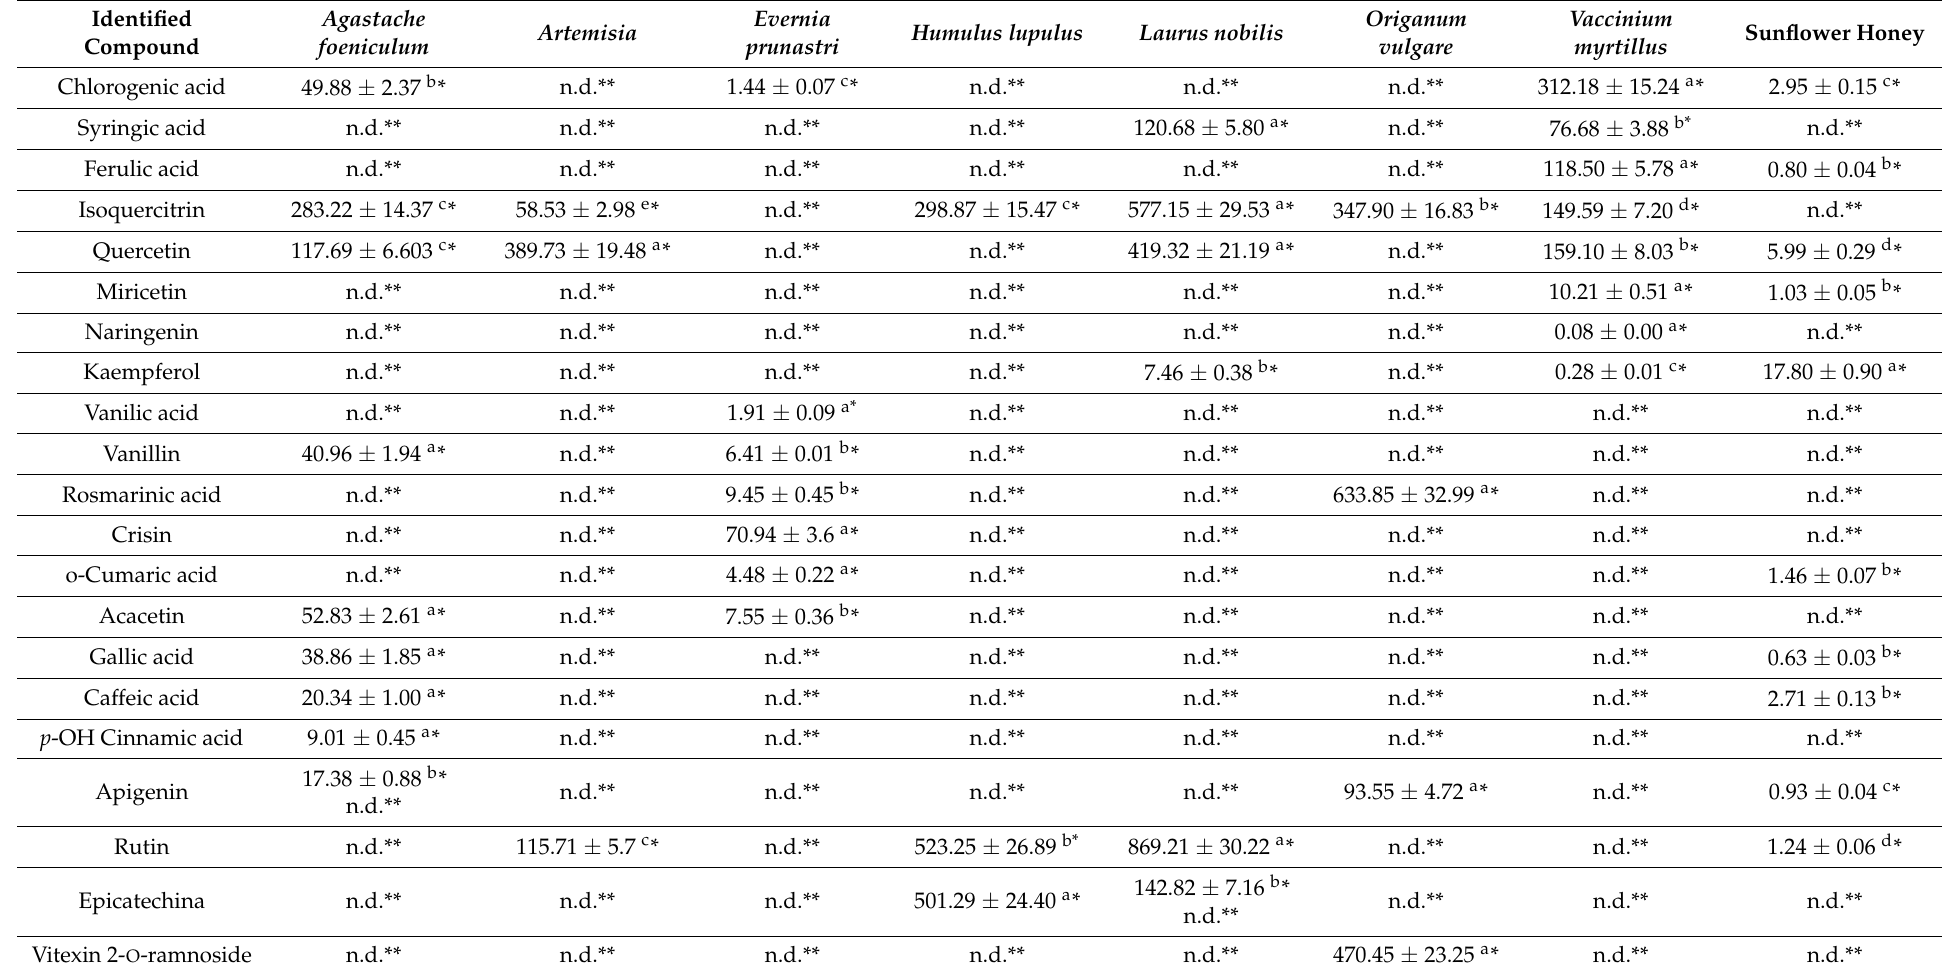
Table 2. Characteristic phenolic acids and flavonoids of Agastache foeniculum, Artemisia absinthium, Evernia prunastri, Humulus lupulus, Laurus nobilis, Origanum vulgare, Vaccinium myrtillus extracts and sunflower honey (expressed as µ g/g dry